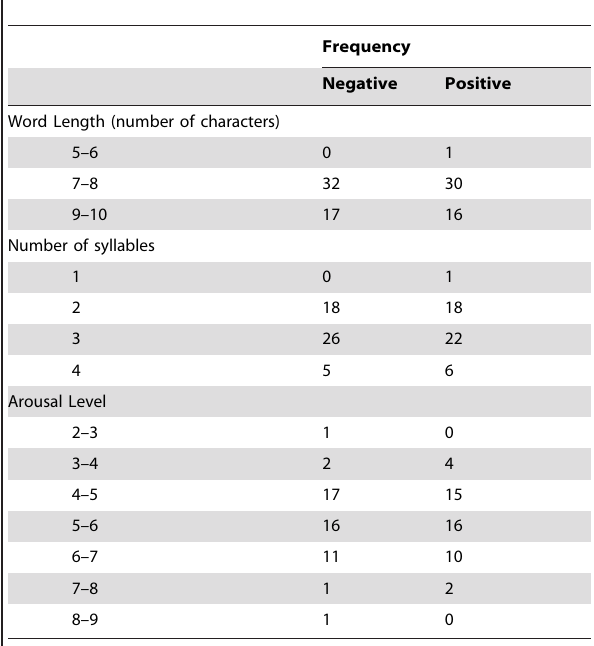
Table 1. Descriptives of the Emotional n -back word